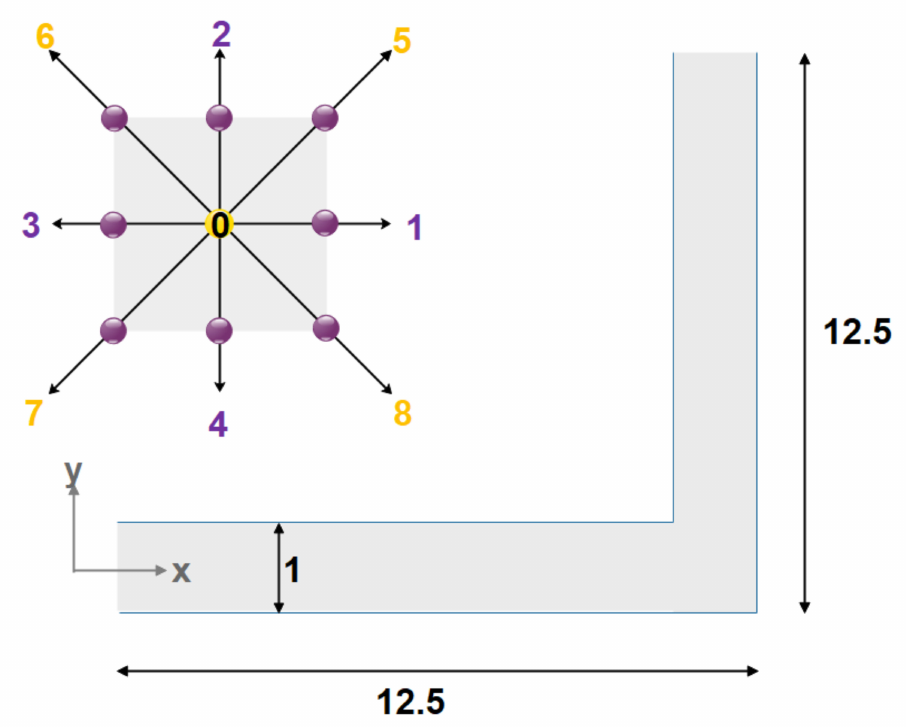
Figure 13. Domain of computation. Computational nodes. There are eight moving particles (num- bered 1–8) and one stationary particle (0) .The arrow that corresponds to a particle’s motion indicates its direction of motion.